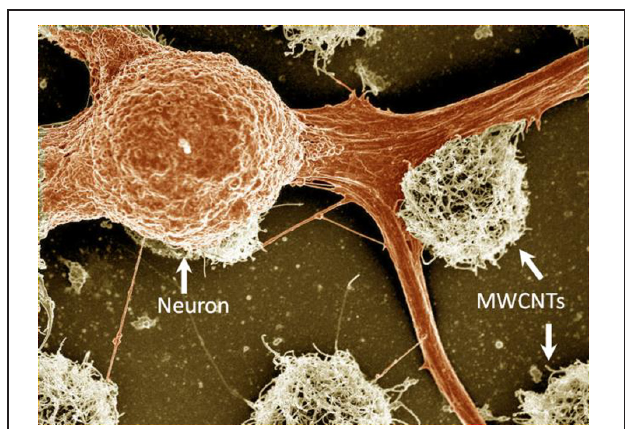
FIGURE 1 | A false-colored SEM image of fixed locust frontal ganglion neuronal cells cultured on carbon nanotube islands. The carbon nanotube islands were grown using the chemical vapor deposition method directly on a quartz support. For further details see Sorkin et al. (2009). Width of field of view is 77 µ